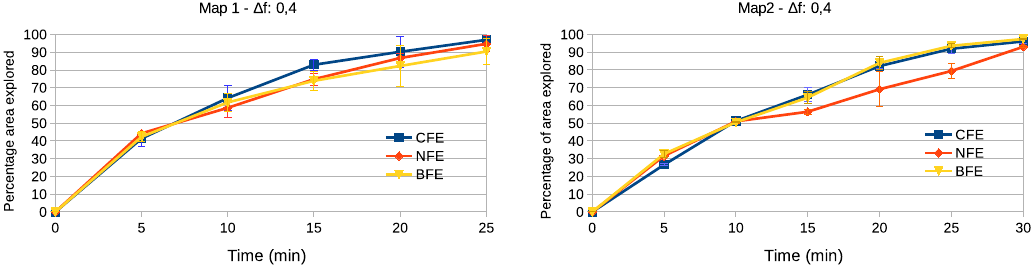
Figure 9. Percentage of ground truth area covered by the proposed approaches. Left: map 1. Right: map 2.